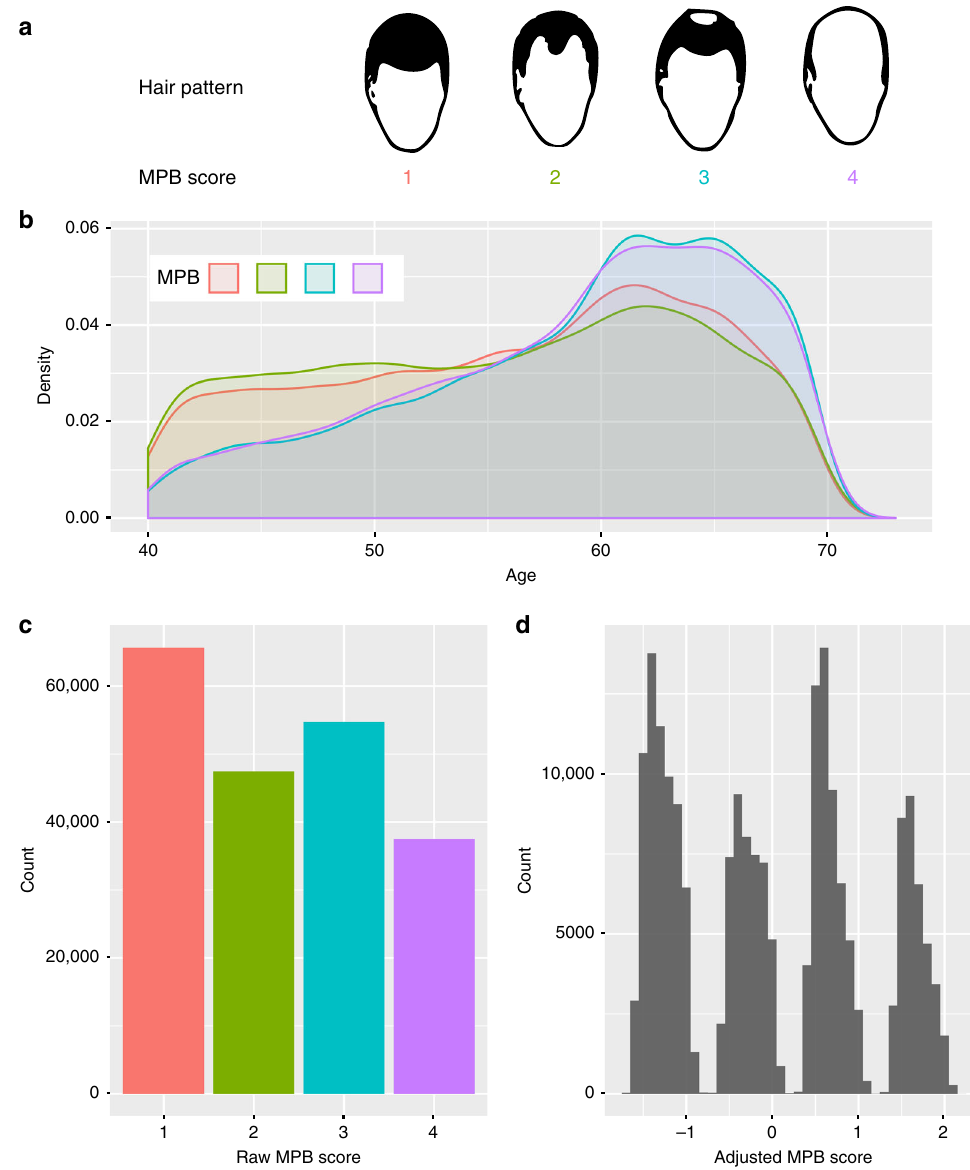
Fig. 1 Summary of the European, genotyped, genetically-male study population ( n = 205,327). a Diagram of hair patterns and corresponding MPB scores, adapted from the UKB baldness survey, accessible at https://biobank.ctsu.ox.ac.uk/crystal/refer.cgi?id = 100423. b Density plots showing the relative age distributions within each MPB score group. c Distribution of raw MPB scores and d adjusted MPB scores (age, assessment centre, ethnicity and 40 principal components calculated using the UKB European